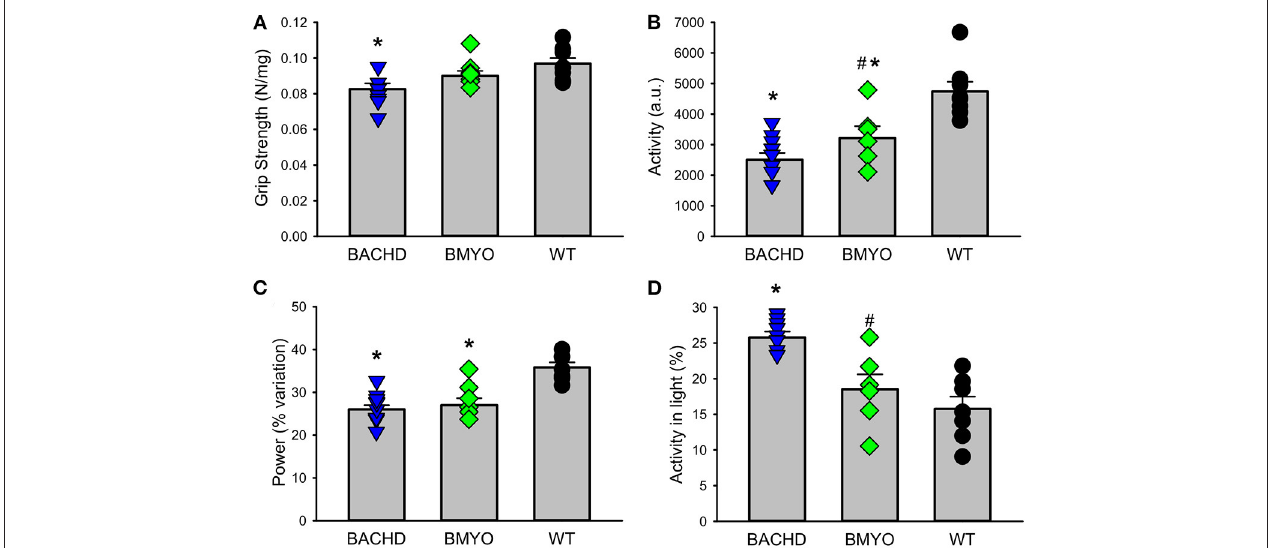
FIGURE 7 | Behavioral biomarkers of cardiovascular function were improved in the BMYO line. Behavior measures including grip strength, and diurnal rhythms of activity of the three lines were measured between 6 and 7 months of age. (A) Grip strength was reduced in the BACHD compared to BMYO and WT lines. (B) The average total activity over 24h as reduced in both the BACHD and BMYO compared to WT. (C) Power, one measure of circadian rhythmicity, was reduced in both the BACHD and BMYO compared to WT controls. (D) The % of activity measured in the light was reduced in the BMYO. The vertical bar plots show group means and SEM. The symbols show the values from individual animals (n = 8 per genotype) in each group. Asterisks represent significant differences ( P < 0.05) compared to WT mice while crosshatch indicates significant differences ( P < 0.05) between BMYO and BACHD mice. One way ANOVA followed by Holm-Sidak or Tukey’s multiple comparison test was used to evaluate the possible significance of the findings. If normality or equal variance tests failed, then Kruskal-Wallis one way ANOVA on ranks followed by Dunn’s multiple comparison test was used instead (see Table 5 ).